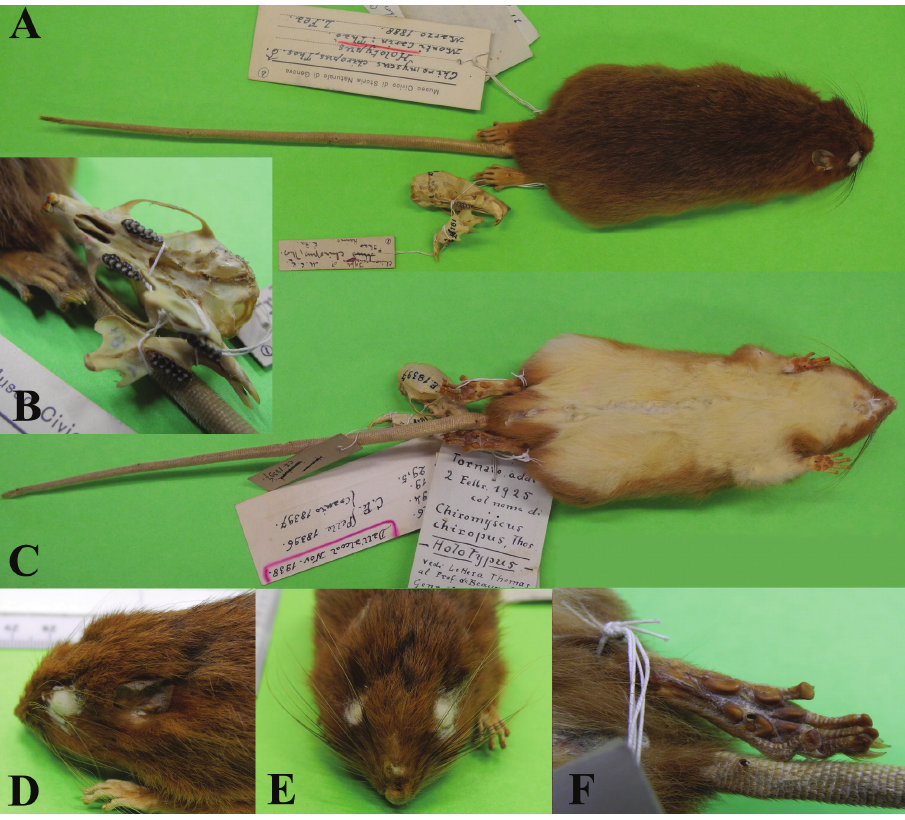
Figure 5. The holotype of Chiromyscus chiropus , stuffed skin (MSNG 18396) and skull (MSNG 18397). A Stuffed skin, dorsal view B Skull, ventral view; hind foot, dorsal view C Stuffed skin, ventral view D Head, lateral view E Head, face view F Hind foot, plantar surface. Images were kindly provided by